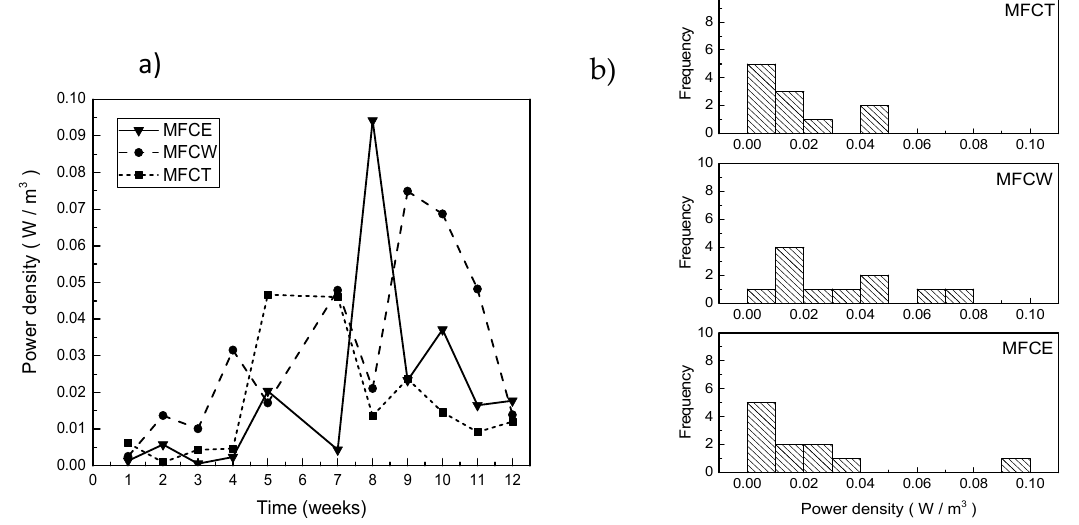
Figure 4. ( a ) Power density in the MFC, ( b ) frequency of generated power.